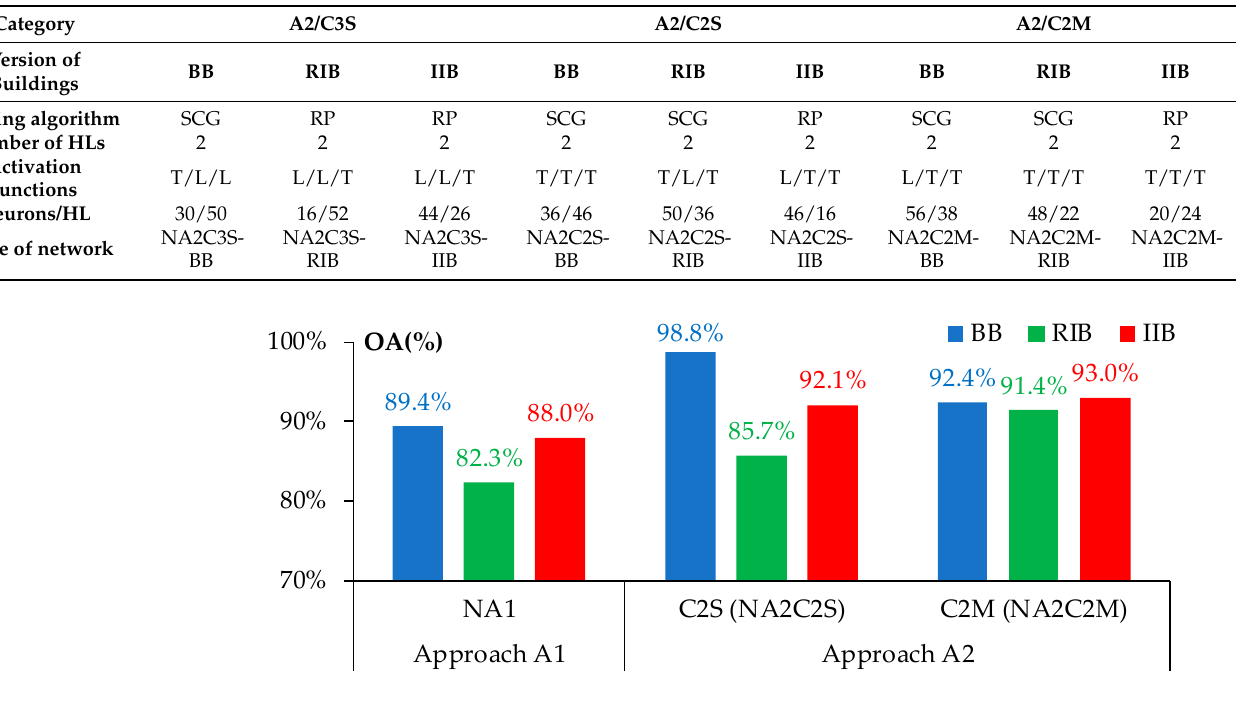
Table 8. Configuration parameters and names of the optimal networks used for the implementation of A2.